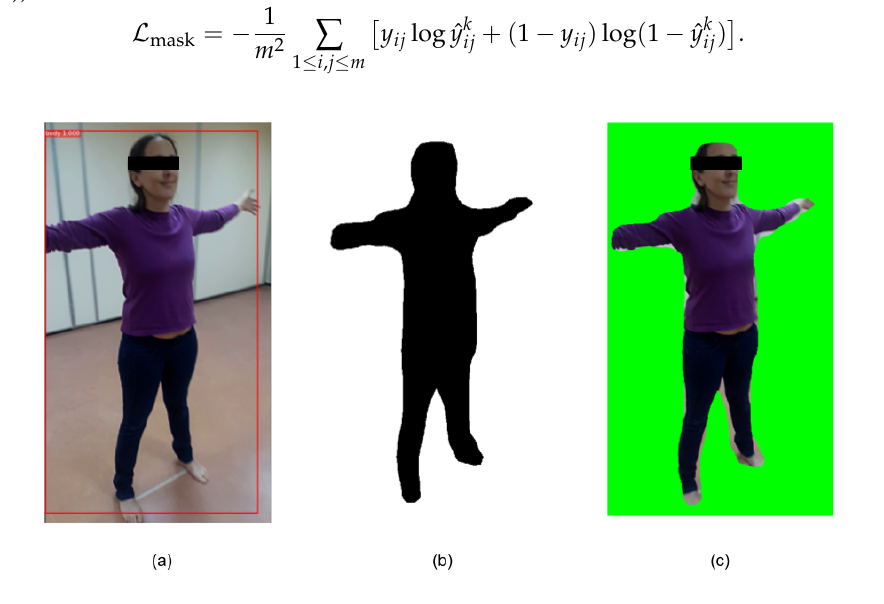
Figure 2. Intermediate results of BRemNet . ( a ) Bounding box, ( b ) Mask, and ( c )